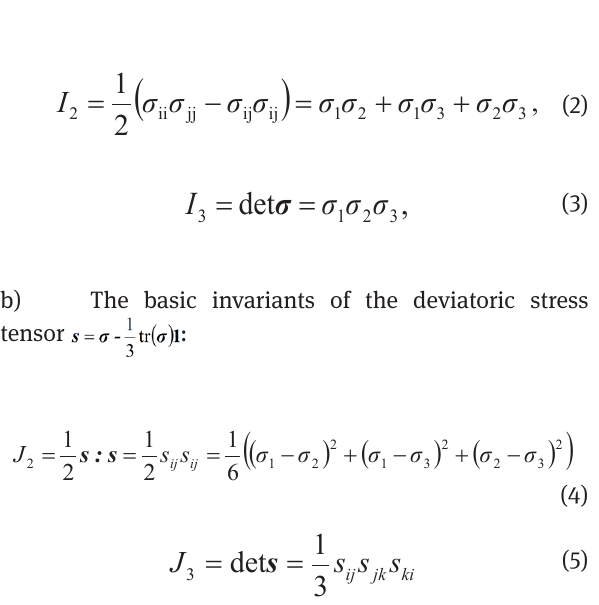
Figure 4: Failure surfaces in the deviatoric plane, see Georgiadis et al. (2004). In plane strain conditions, Lode angle varies roughly from q = 10 ̊ to q = 20 ̊